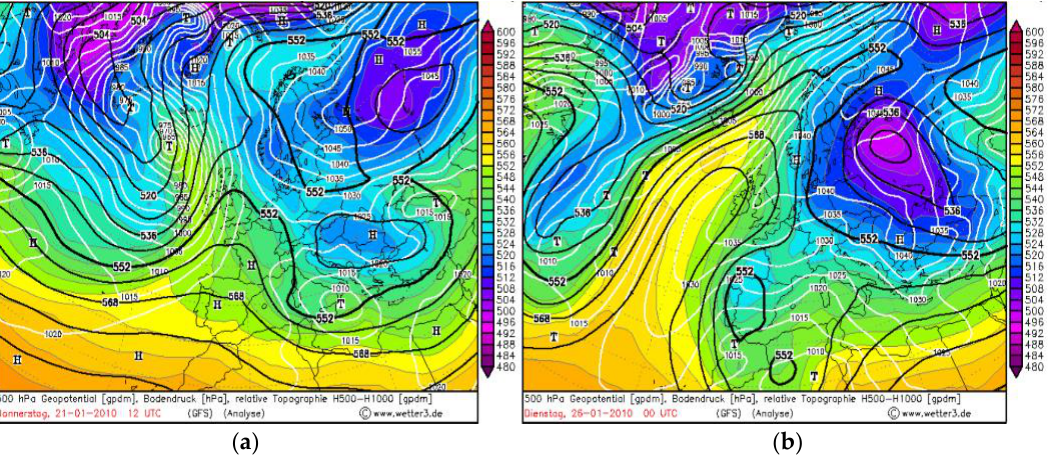
Figure 7. Weather maps for 21 January ( a ) and 26 January ( b ) 2010. These maps show the 500 hPa geopotential (black contours), sea-level pressure (white contours) and relative topography H500–H1000 (color scale) [15].